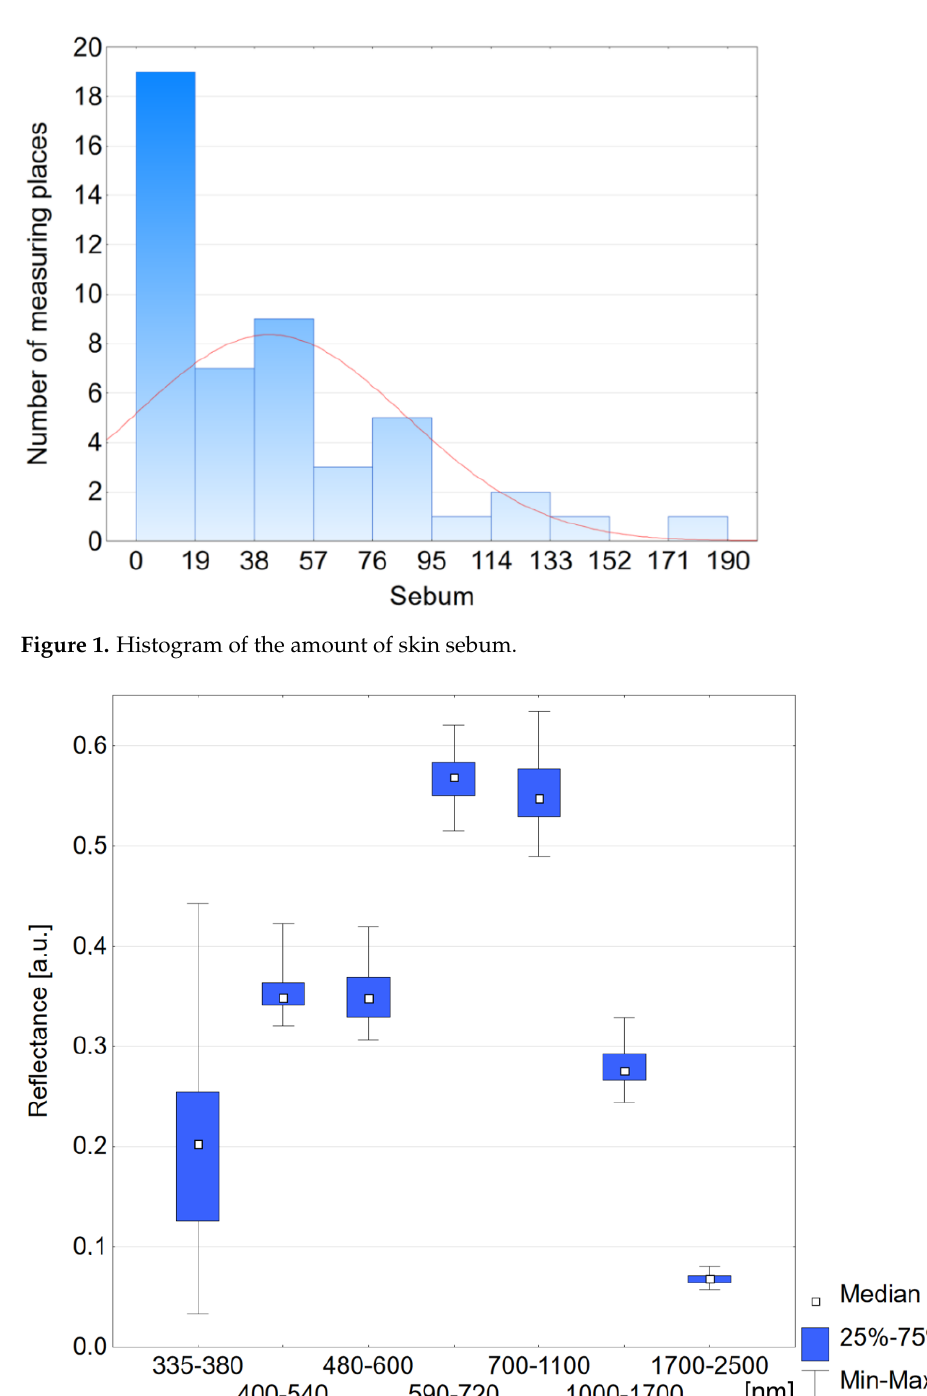
Figure 2. Directional reflectance values of the skin at different wavelength ranges. Spearman’s rank correlation analysis between the amount of sebum and the value of directional reflectance of the skin measured at the wavelength 335–380 nm showed no statistically significant relationship between the two variables (R = 0.14; p = 0.360) (Figure